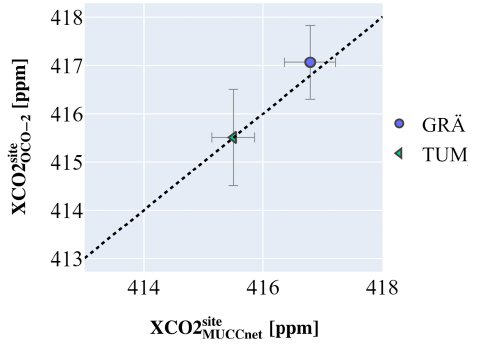
Figure 13. X CO captured by OCO-2 and MUCCnet on 18 Decem- Figure 14. ERA5 wind rose ± 2h of overpass 2